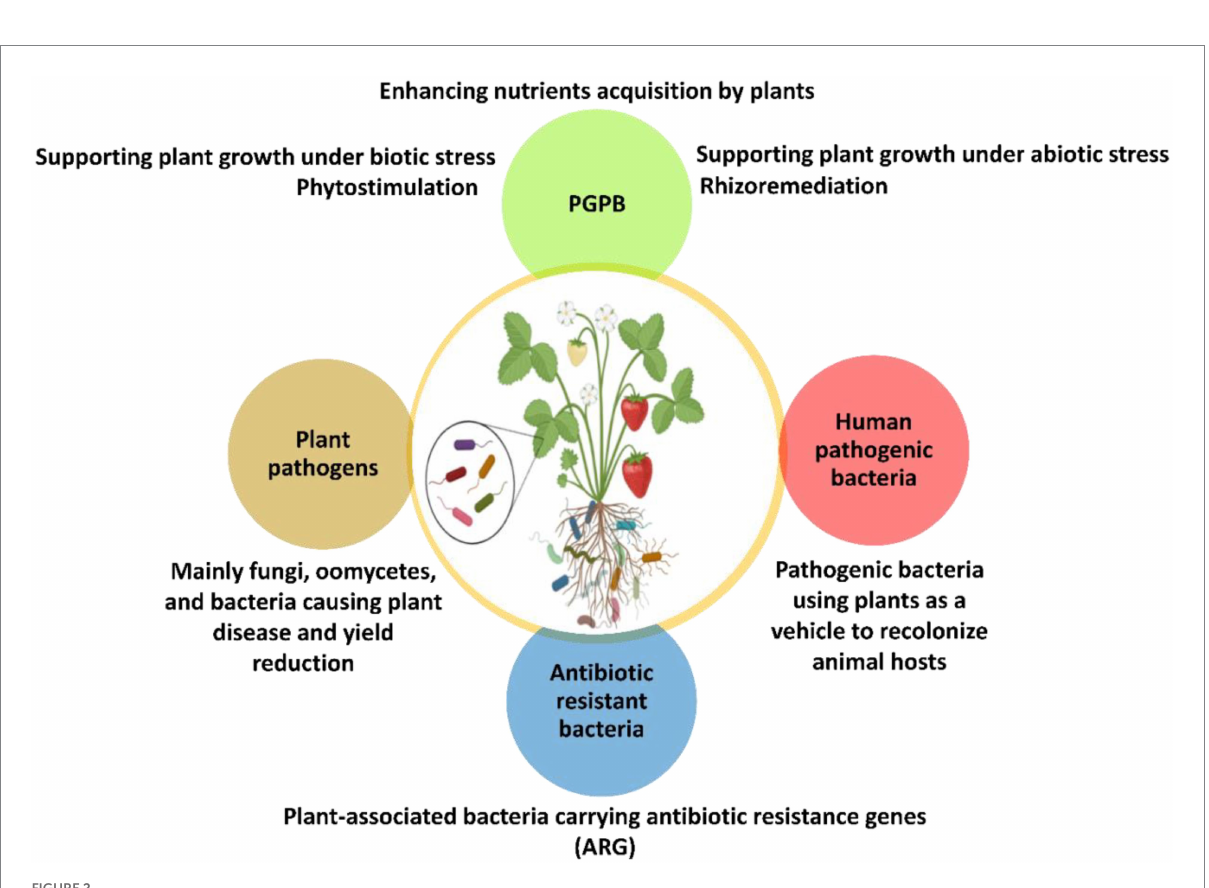
FIGURE 2 Schematic overview of plant-associated microorganisms and their respective functions. They live inside the plant tissues as endophytes or surrounding the root system as rhizosphere microorganisms. PGPB, Plant growth promoting